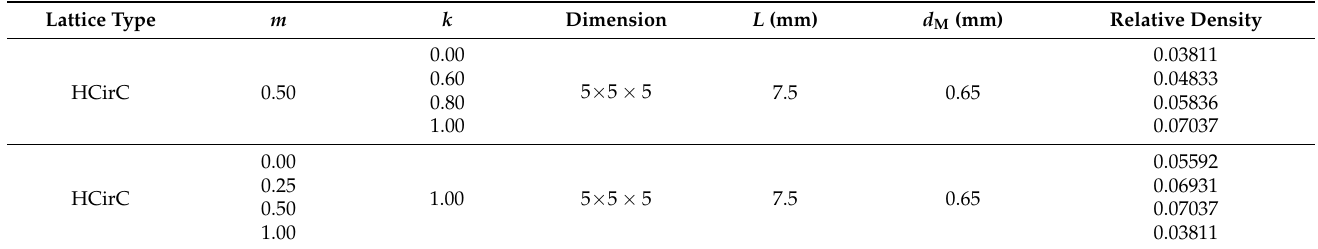
Table 4. The geometrical parameters of hierarchical lattice HCirC with different m and k values, and the mass of the fabricated samples.